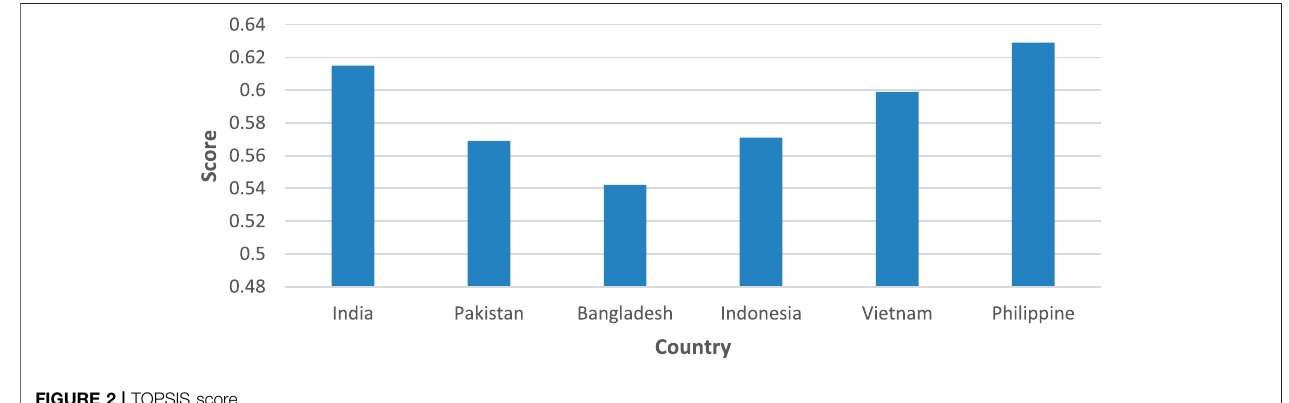
FIGURE 2 | TOPSIS score.